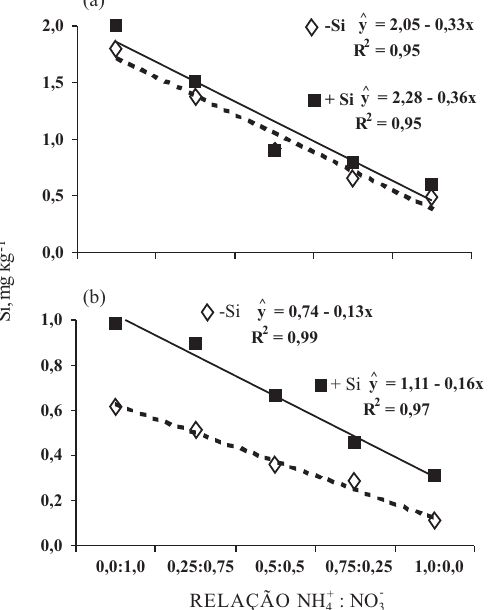
Figura 3. Teor de silício disponível no solo, extraído por CaCl , em função de diferentes relações N- , em função de 2 2 NH 4+ : NO 3- , na presença e ausência de Si no cultivo de arroz. (a) solo não-rizosférico; (b) solo